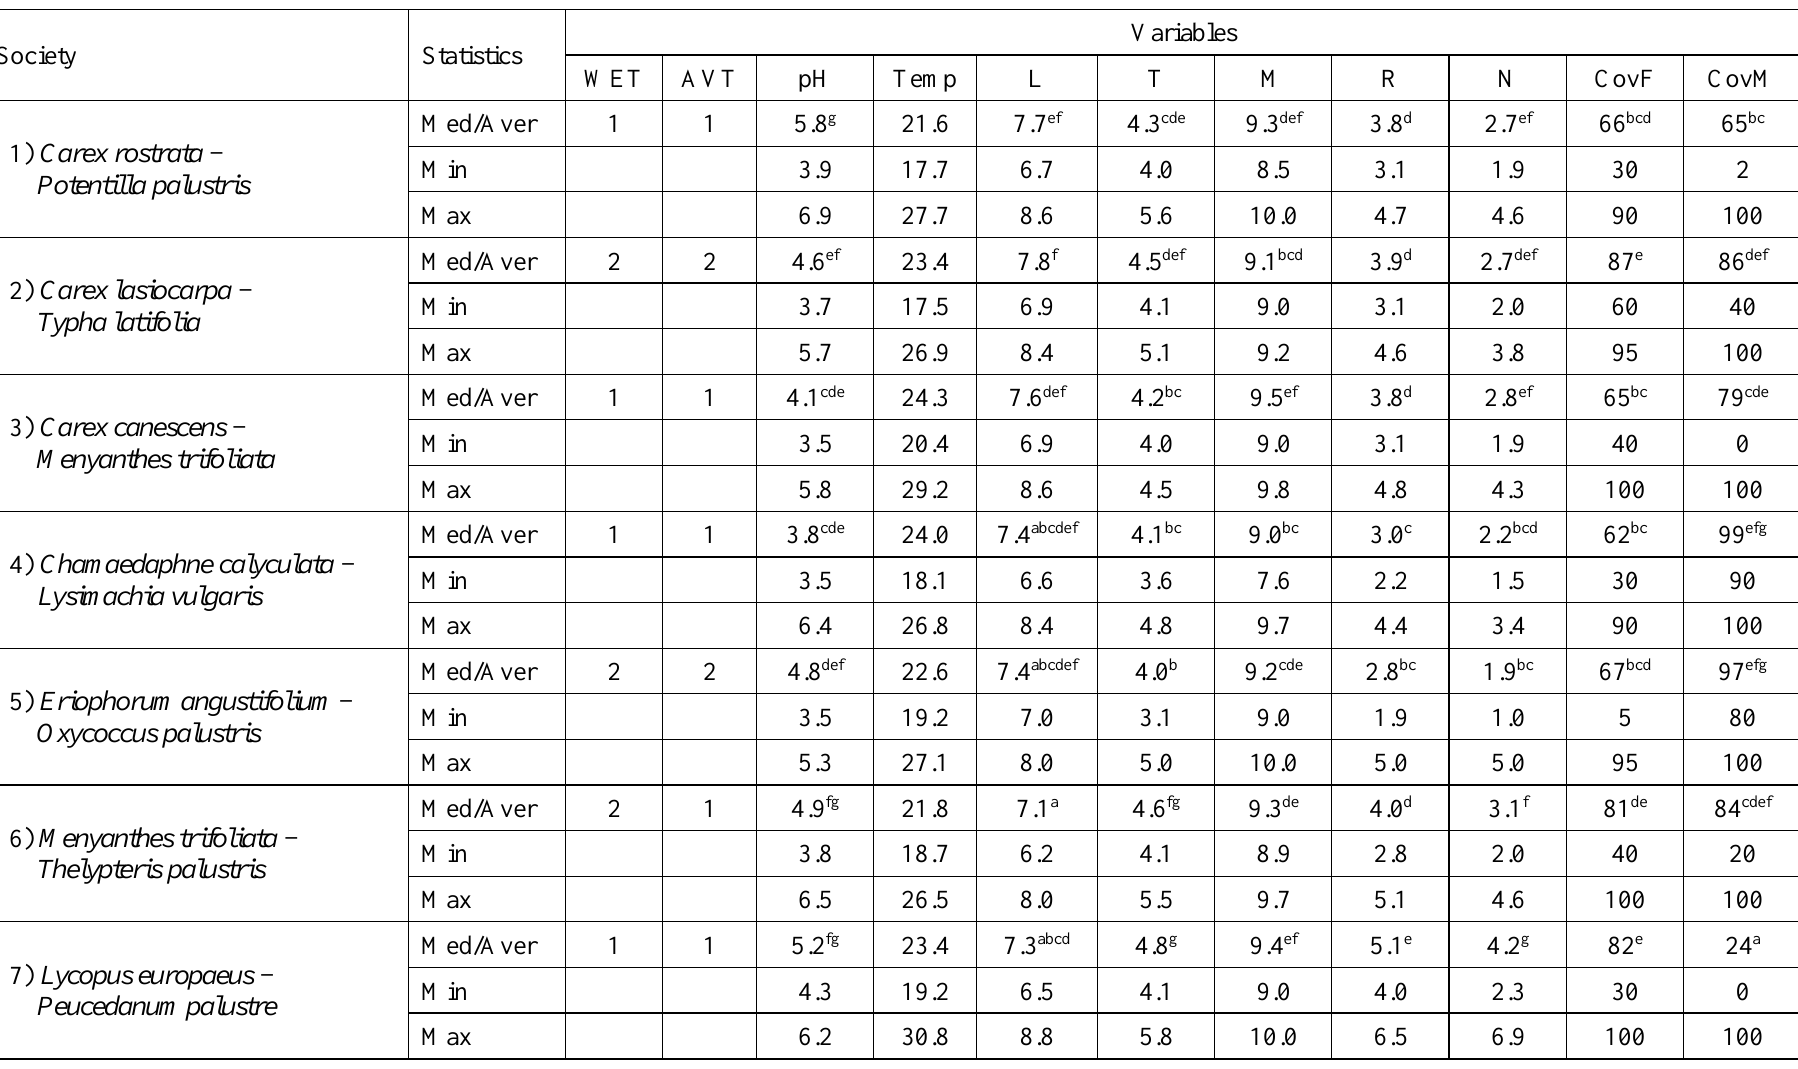
Table 6. Median values of peat-water pH and average values of other environmental variables of vascular plant societies. Notation: WET = lake water exchange type, AVT = adjacent vegetation type; other notations as in Table